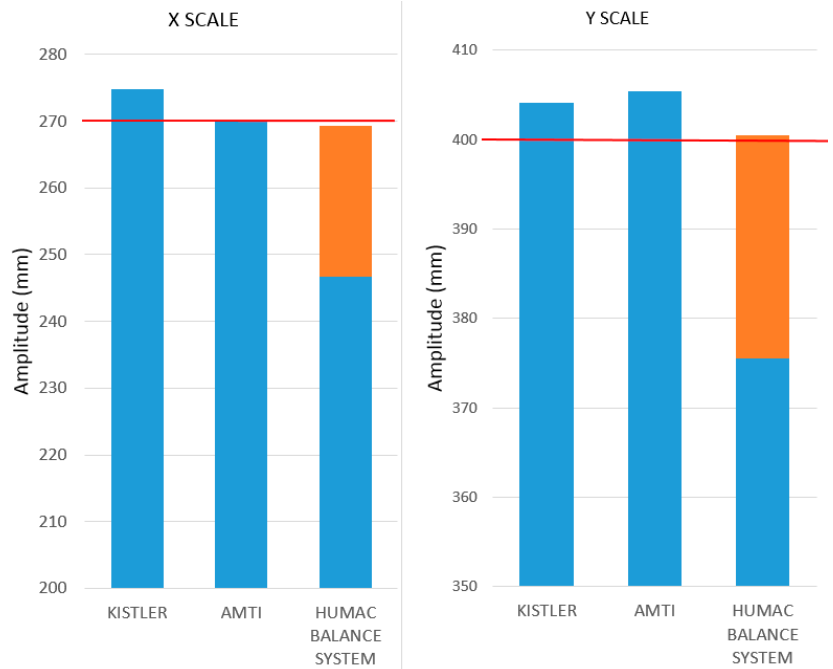
Figure 5. Representation of the mean amplitudes (blue column) of the three measurement systems. The red line depicts the expected value. For the HUMAC Balance System, the orange part of the column shows the change of the mean value through calibration.